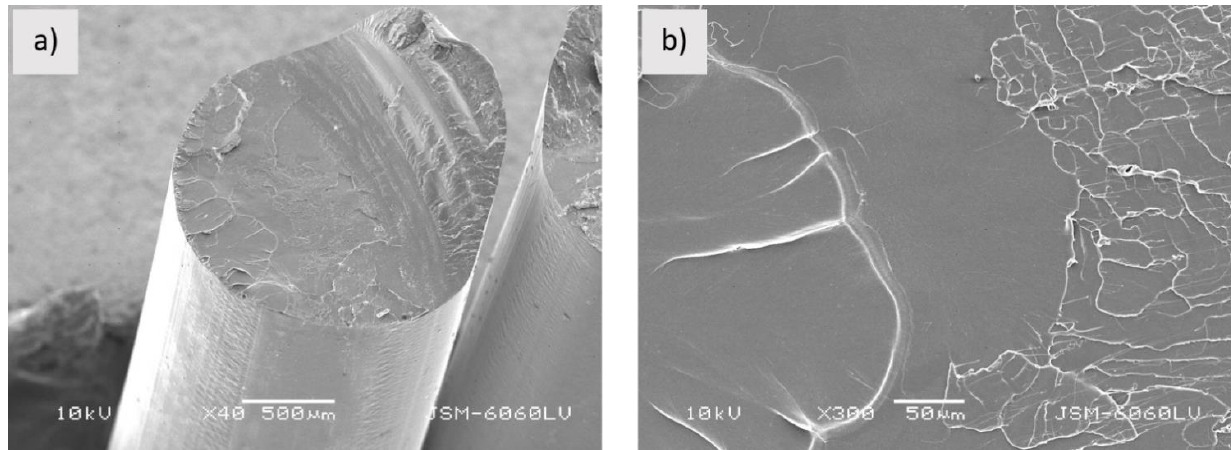
Figure 1. Sample PLA_f; ( a , b ) fractured surface (mag. ( a ) 40×, ( b ) 300×).